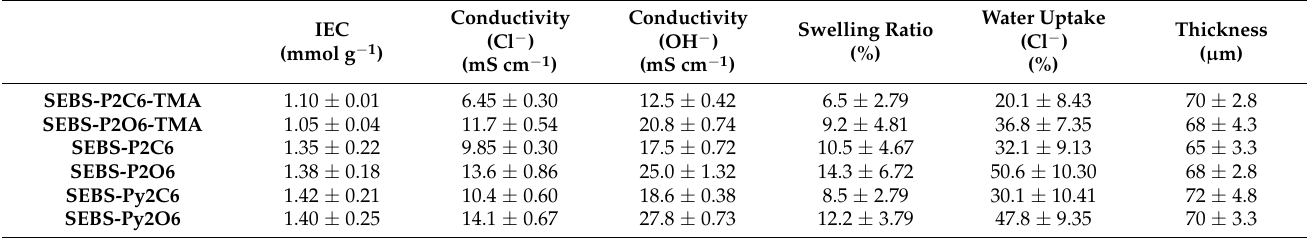
Table 1. IEC, conductivity, swelling ratio, and water uptake of the membrane at 25 ◦ C. IEC (mmol g − 1